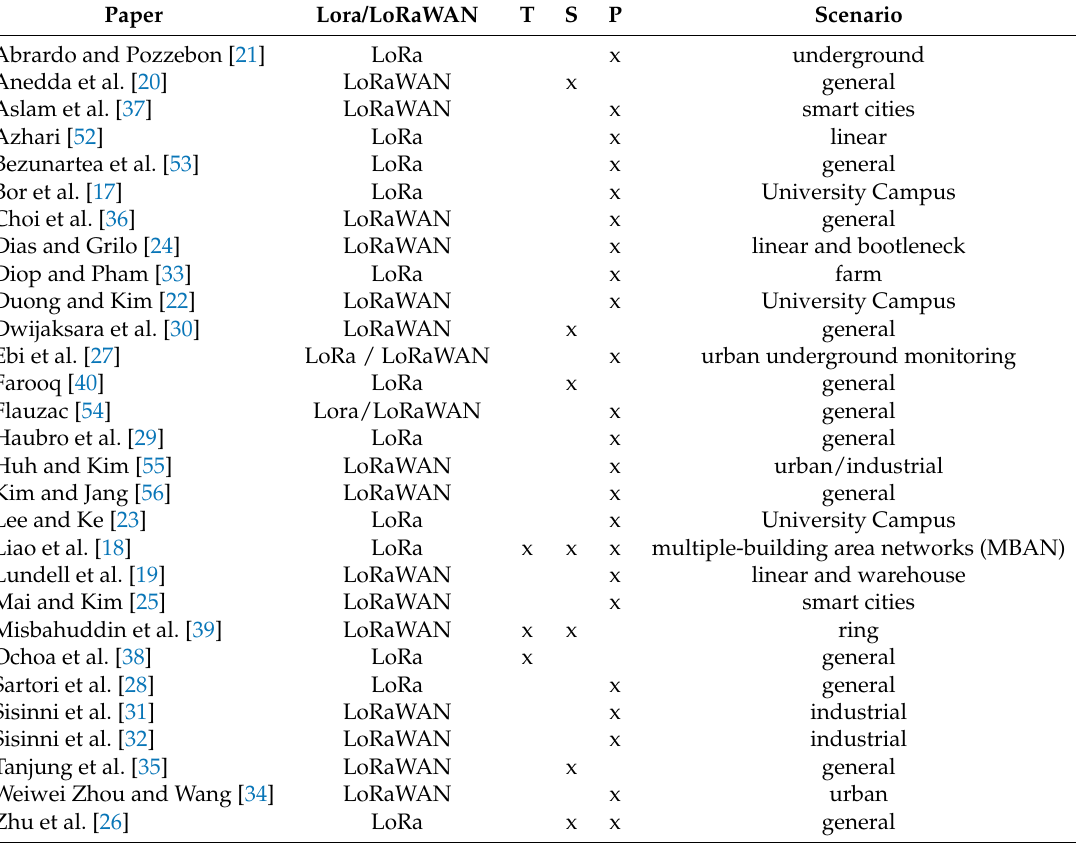
Table 2. Related work on multihop